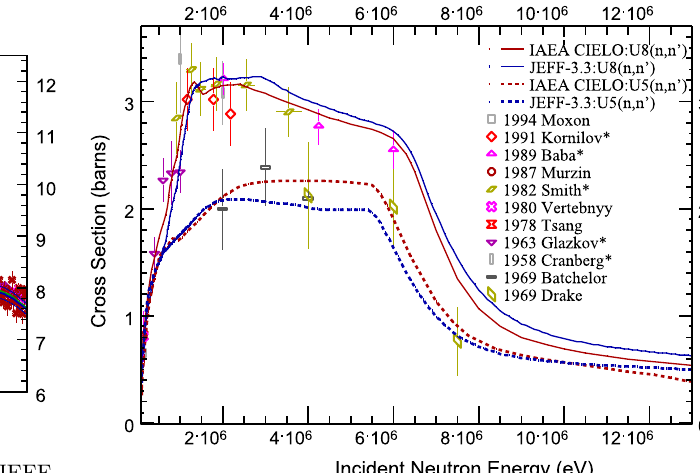
Fig. 2. Evaluated 238 U ( n , n ’ ) and 235 U ( n , n ’ ) cross sections from IAEA CIELO and JEFF-3.3 libraries compared to selected experimental data from EXFOR [20].